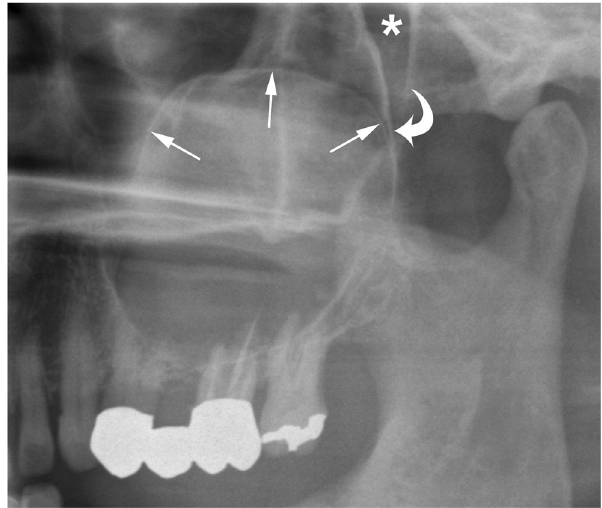
Fig. 4 Cropped panoramic radiograph of the posterior left maxilla demonstrates a large OKC extending into the maxillary sinus ( arrows ). The posterior wall of the maxillary sinus ( curved arrow ) and the pterygopalatine fossa ( asterisk ) are also displayed